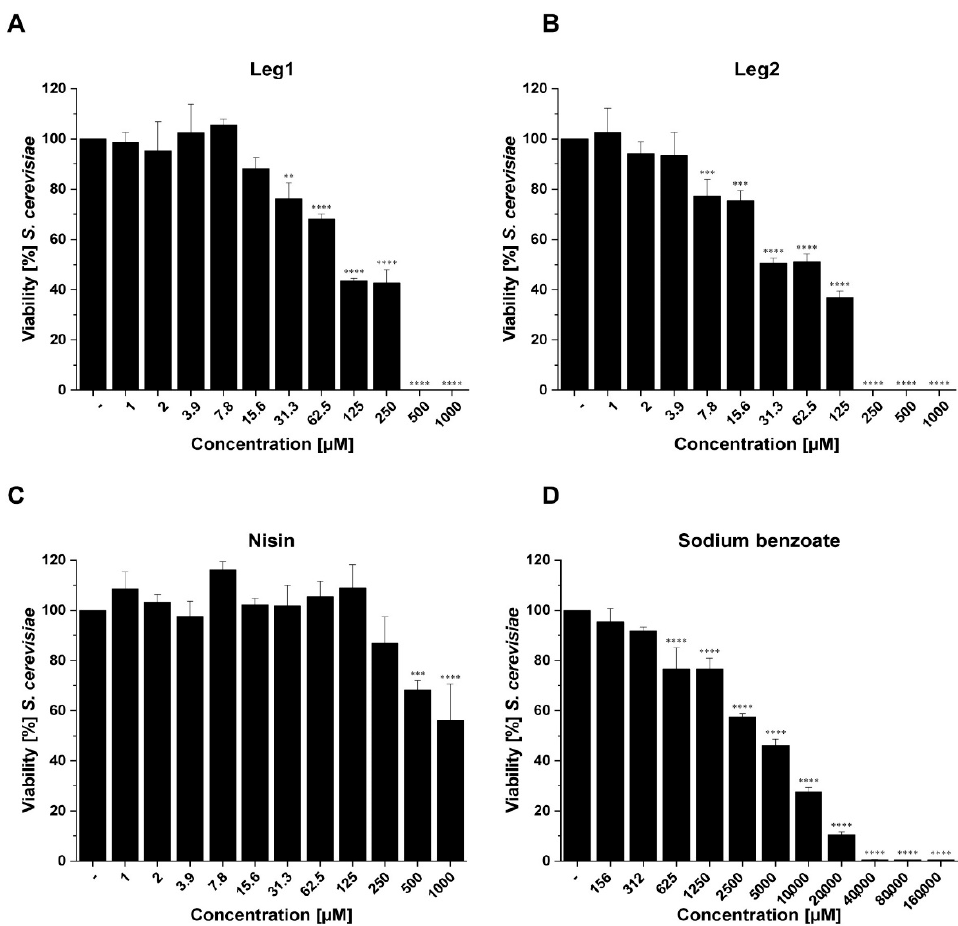
Figure 3. Results of the flow cytometry measurement of antifungal activity using ( A ) Leg1, ( B ) Leg2, ( C ) nisin, and ( D ) sodium benzoate against S. cerevisiae . Water ( − ) was used as negative control. Viability (as mean ± SD of triplicates) is expressed as percentage in relation to the negative control. The levels of significance were * p < 0.05, ** p < 0.01, *** p < 0.001, **** p < 0.0001.